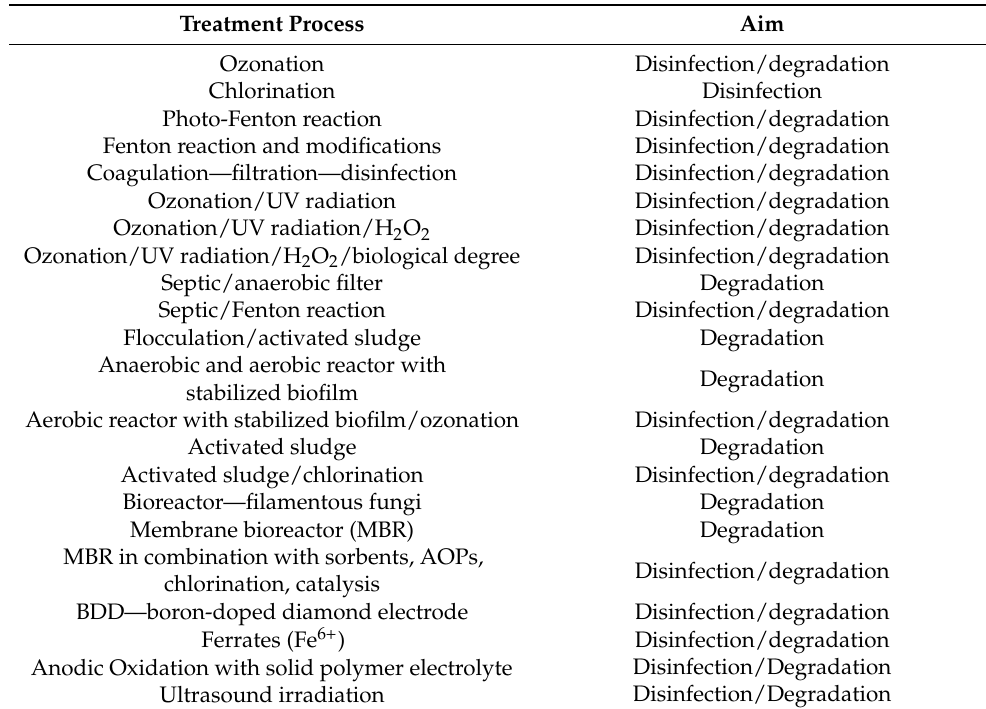
Table 4. Technological processes and their combinations in the treatment of wastewater from healthcare facilities